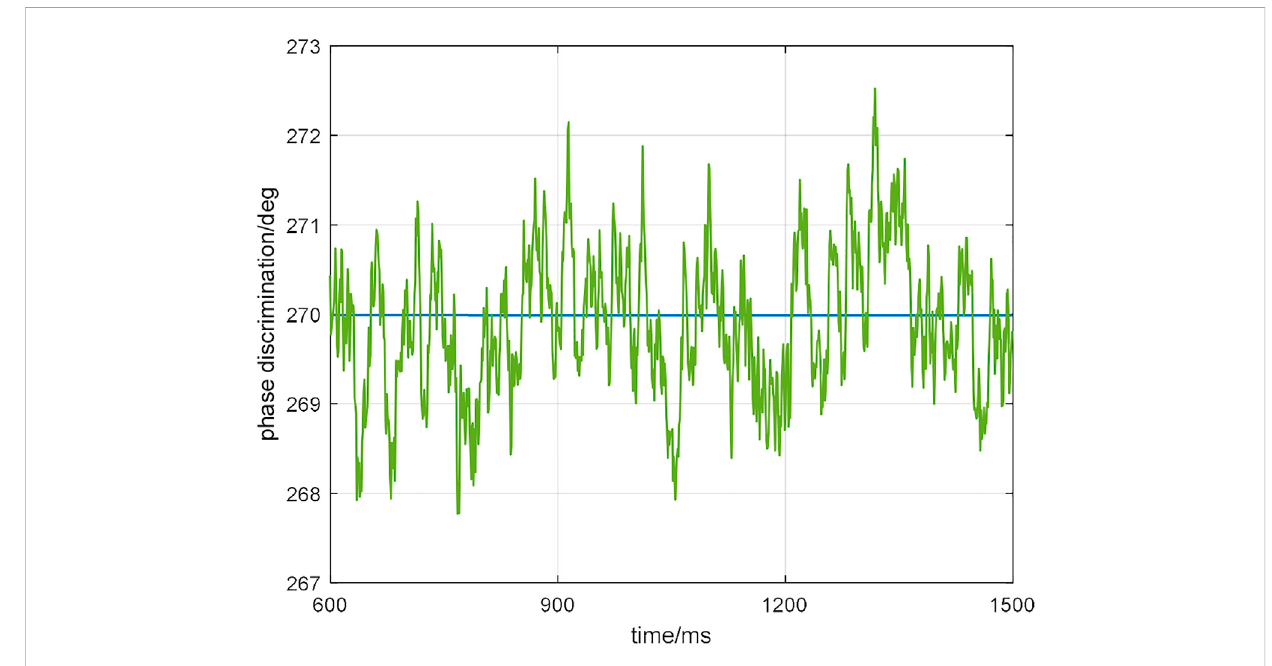
FIGURE 7 The carrier phase comparison